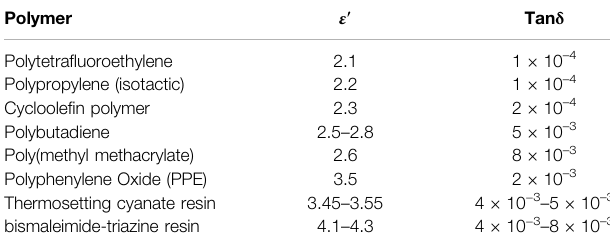
TABLE 1 | The ε ′ and tan δ of Representative